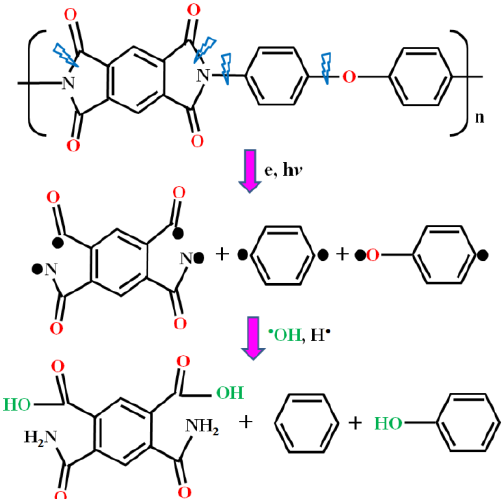
Figure 11. Modification mechanism of PI film by Ar/H 2 O microplasma jet in ambient air